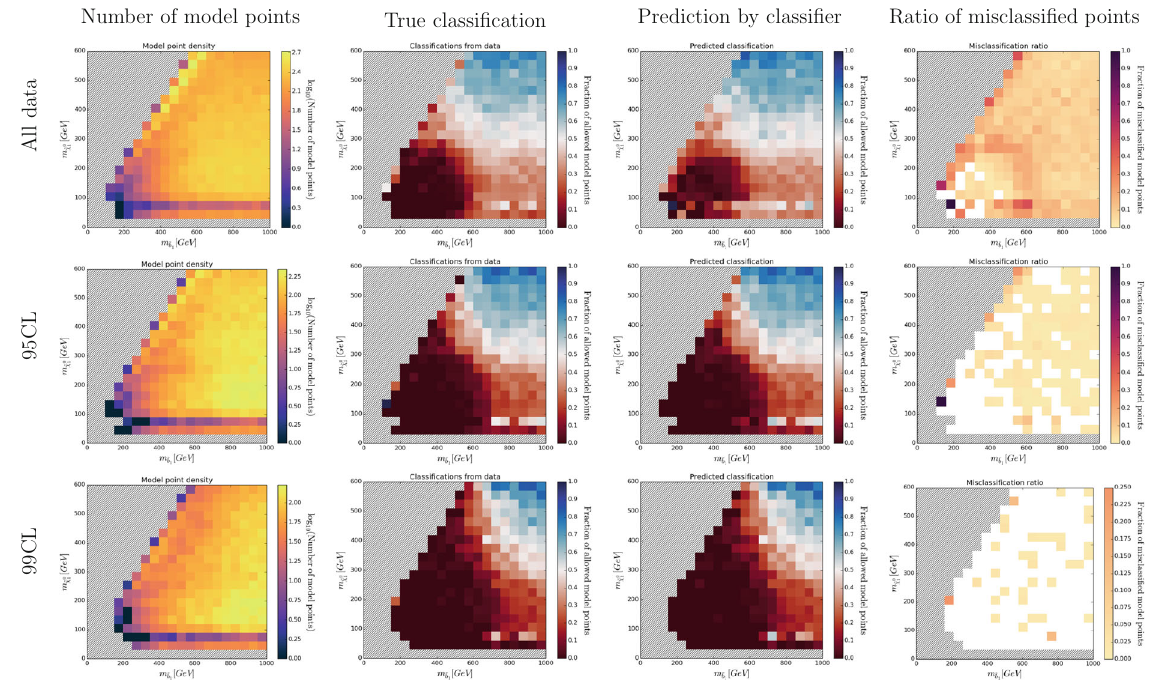
true classification and the out-of-bag prediction, respectively. The last Fig. 13 Color histograms for a projection of the 19-dimensional column shows the fraction of misclassified model points. The dashed pMSSM parameter space on the m ˜ – m ˜ χ 0 plane. The color in the sec- b 1 1 bins contain no data points. Cf. Fig. 7a of Ref. [6] ond and thirdcolumn indicatesthefractionofalloweddatapointsforthe